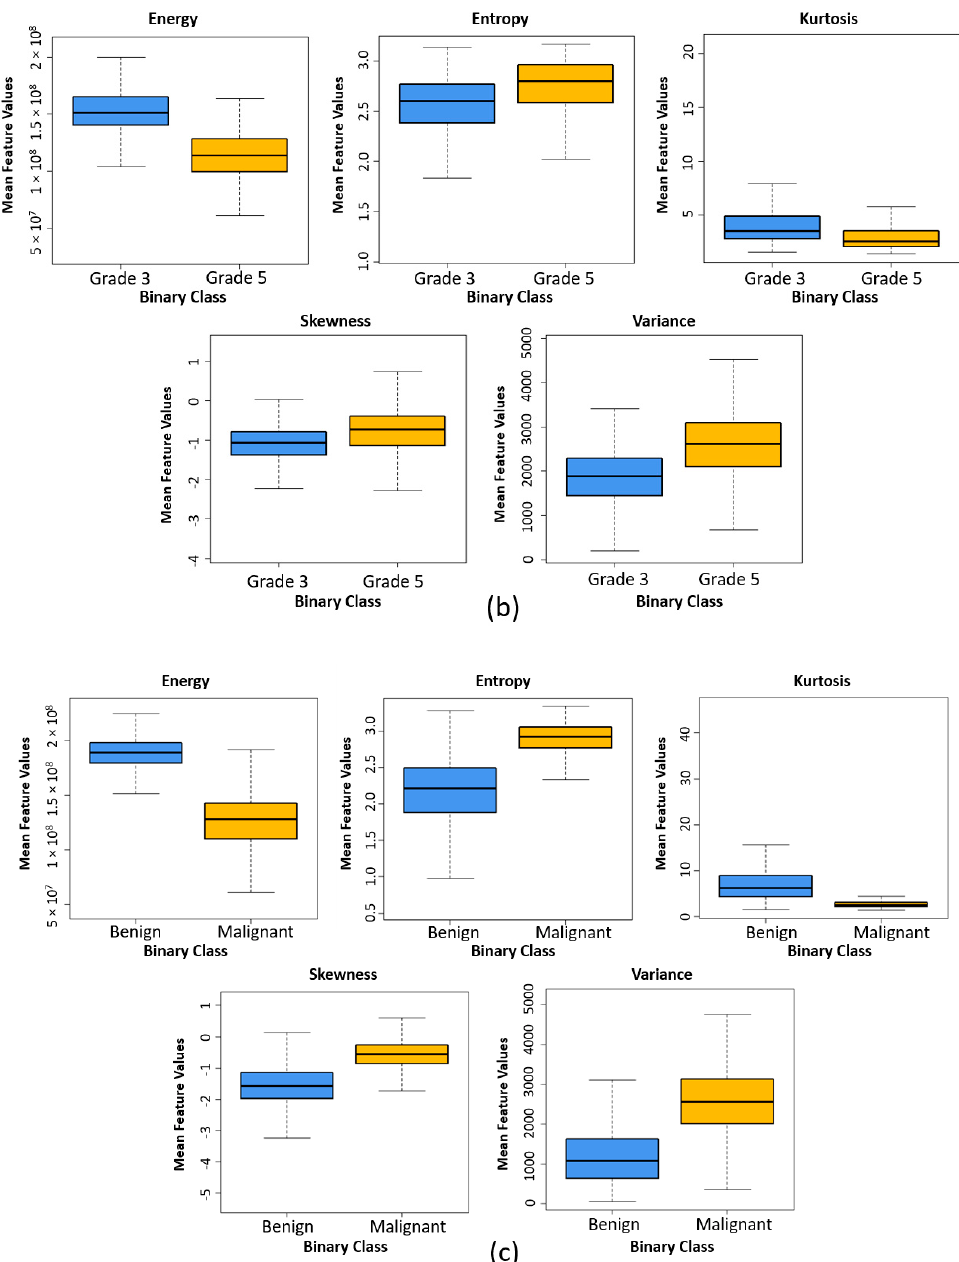
Figure 9. Comparing the texture differences between benign and malignant tissue and grade 3 and grade 5 tissue samples using five high-ranked radiomic features. ( a ) Box plot comparing the five high high-ranked radiomic features between benign and malignant (internal test set). ( b ) Box plot comparing the five high high-ranked radiomic features between grade 3 and grade 5 (internal test set). ( c ) Box plot comparing the five high high-ranked radiomic features between benign and malignant (external test set).